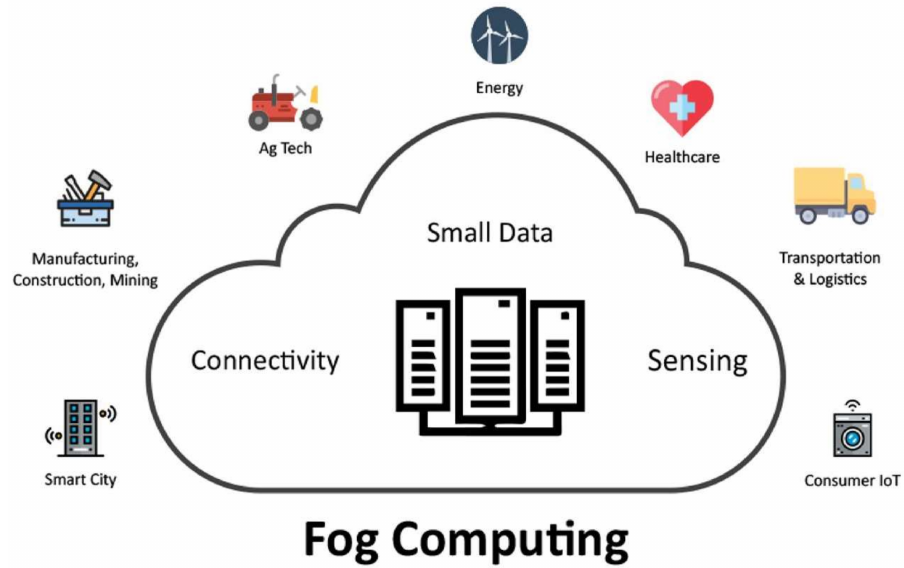
Figure 3. Fog computing supports many IoT applications to provide better service to customers.